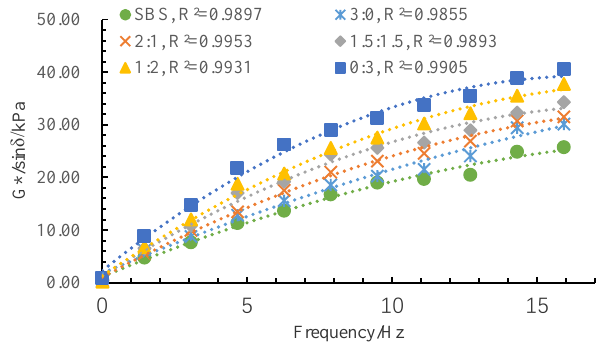
Figure 12. Test results of rutting factor.